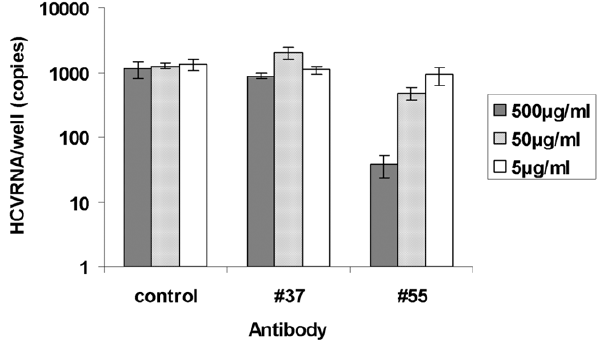
Figure 7. Blocking of viral adsorption by # 55. Blocking of viral adsorption measured by RT-qPCR. Compared to the control antibody (human IgG), # 55 inhibited viral adsorption in dose-dependent manner. Inhibition by # 37 was not observed but rather slightly enhanced at a concentration of 50 m g/ml. doi:10.1371/journal.pone.0055874.g007 PLOS ONE |